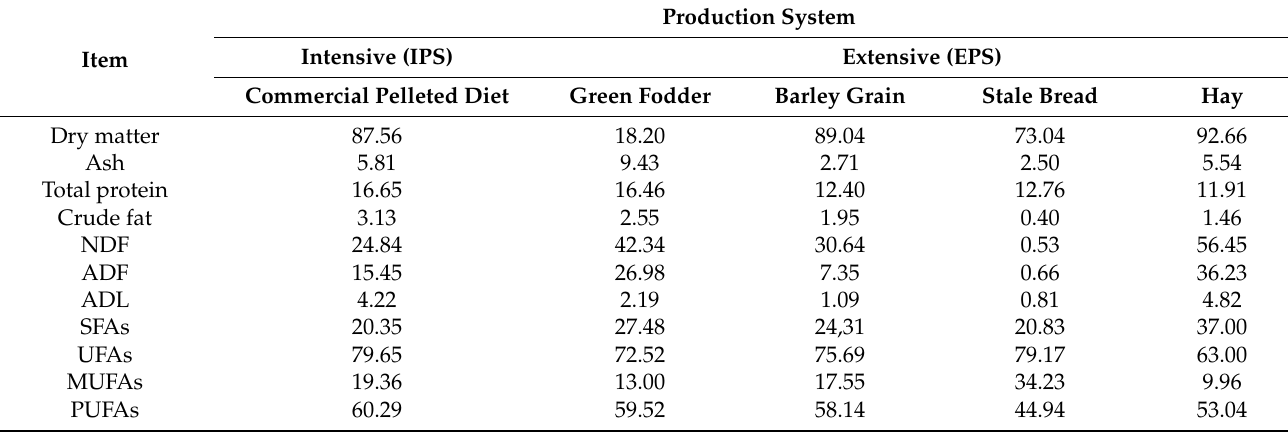
Table 1. Chemical composition (% of dry matter) and fatty acid profile (% of fatty acid groups in total fatty acids) of experimental diets fed to